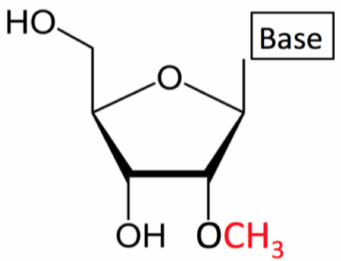
Figure 1. 2 (cid:48) -O-methylated ribonucleoside (Nm): A –CH 3 group is replacing the –H at the position 2 (cid:48) in the ribose moiety. This modification can appear on any nucleotide regardless of the type of nitrogenous base